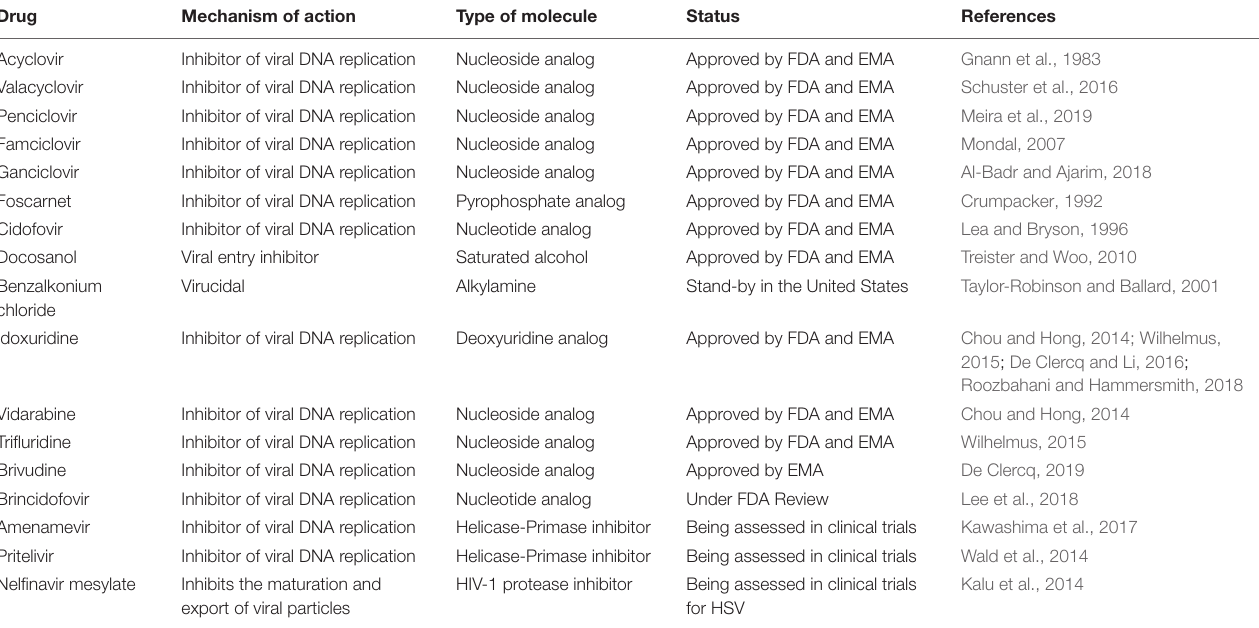
TABLE 1 | Approved and experimental antiviral drugs against HSV-1 and HSV-2